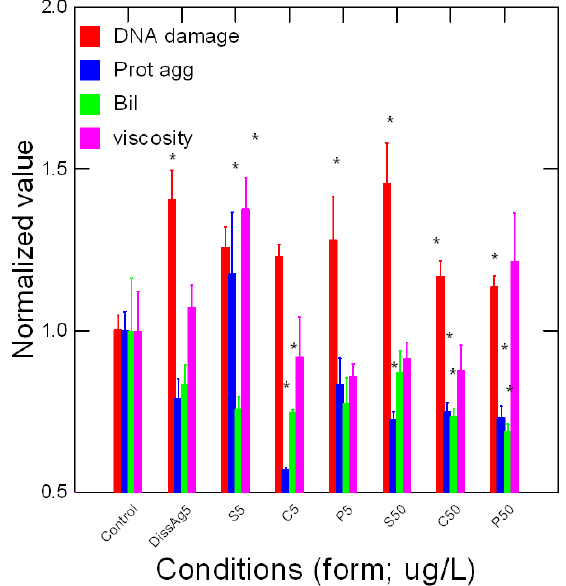
Figure 5. Tissue damage in trout exposed to nAg forms. Tissue damage was evaluated by DNA strand breaks, protein aggregation, and heme degradation (bilirubin) in trout gills exposed to forms of Ag. The data represent the mean with standard error. The star * symbol indicates significance at p ≤ 0.05 compared to controls.